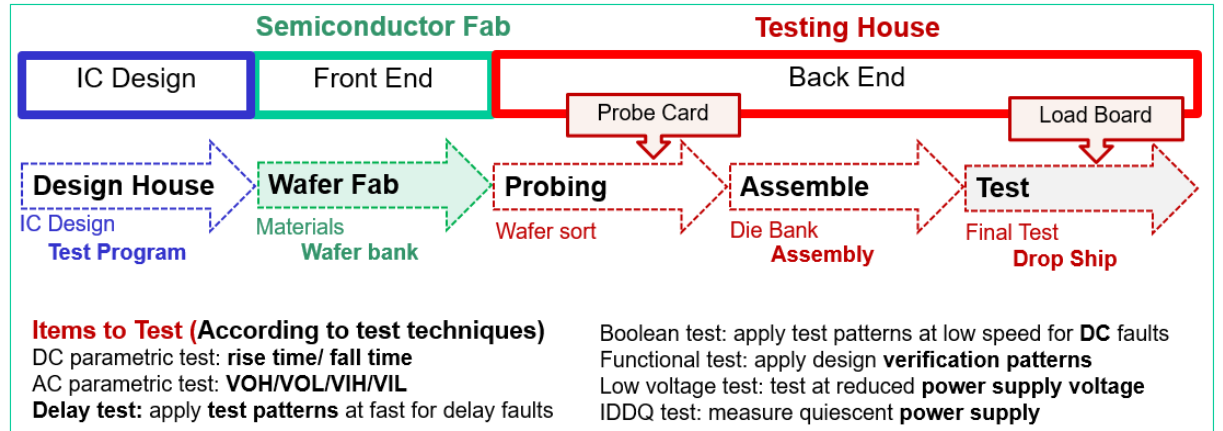
Figure 3. Schematic diagram of the chip development and testing process.